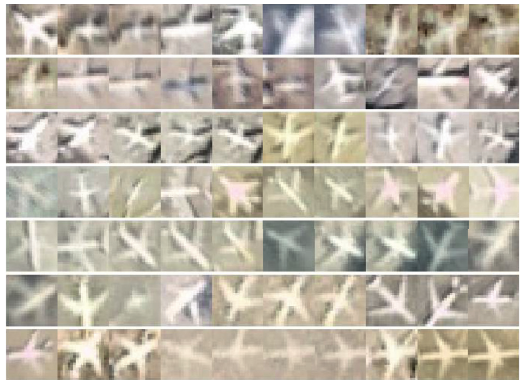
Figure 1: Example of images in the PlanesNet dataset labeled as the “plane” category.